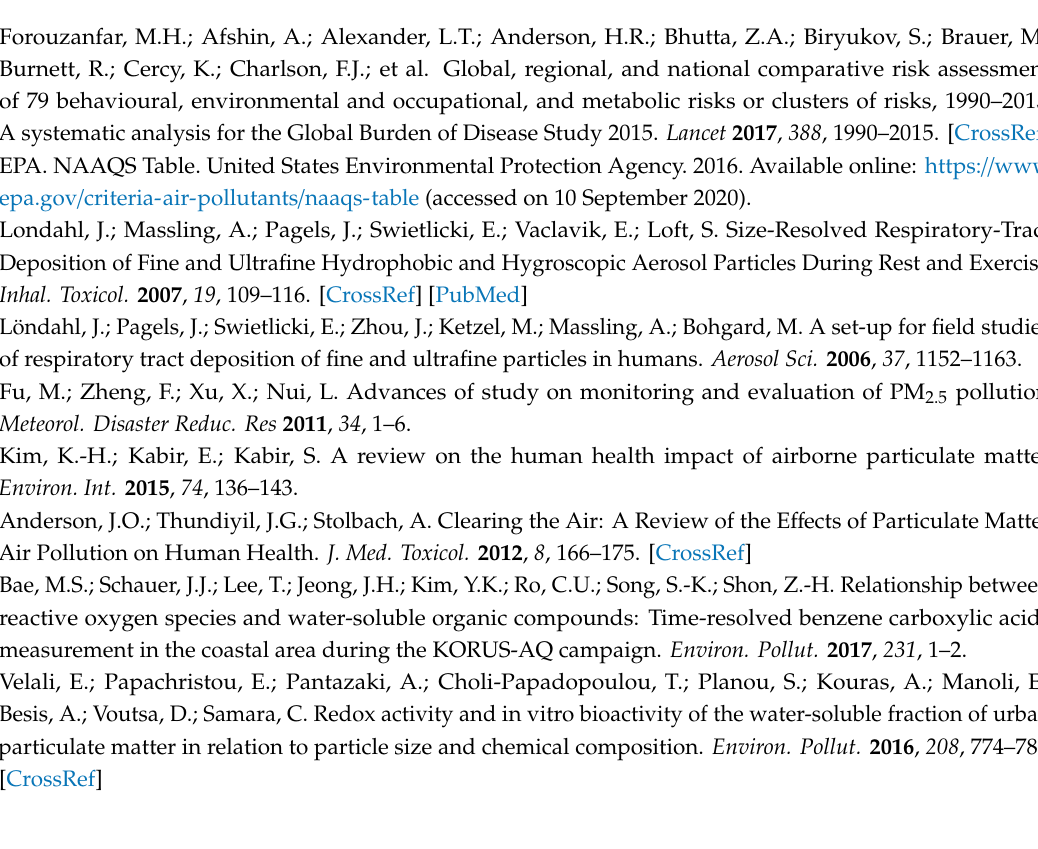
Figure S1: Mean daily Minimum Temperature (°C). (a) Maximum Temperature (°C); (b) and Precipitation (mm); (C) in Central Addis Ababa during 2015–2016. Figure S2: Fine PM Monitoring stations in Addis Ababa, Ethiopia. NMA PM 2.5 Sampler (Met Station site—this study); US Diplomatic Post BAM Monitors (Central and School sites) are shown in figure with blue pin. Figure S3: The percentage contribution of major mass constituents of PM 2.5 in Central Addis Ababa. Table S1: Crustal Enrichment Factor (CEF > 10) of 15 trace elements identified from PM 2.5 samples in central Addis